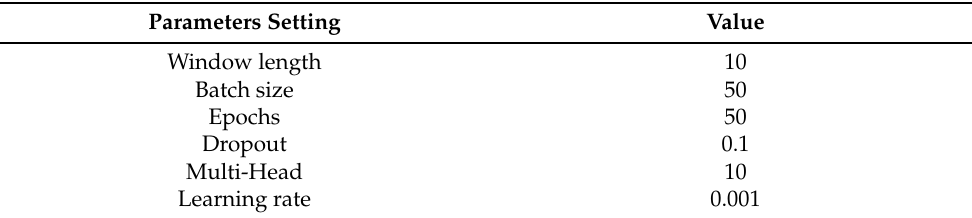
Table 1. Parameters of